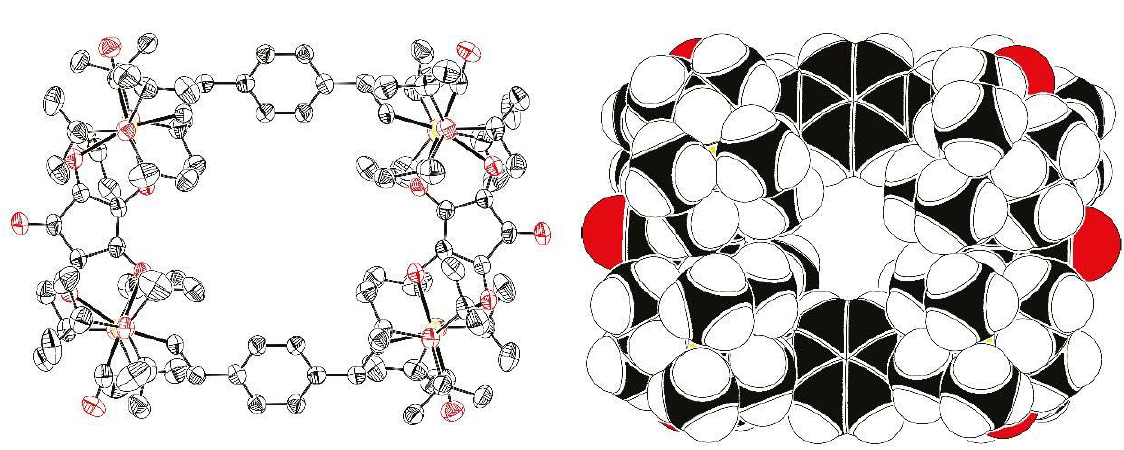
Figure 5. ORTEP representation ( left ) and space-filling model ( right ) of the molecular structure of 2 Ru 2 Ph-Croc in the single crystal. Thermal ellipsoids are displayed at 50% probability. Hydrogen and solvate atoms are omitted for clarity reasons.